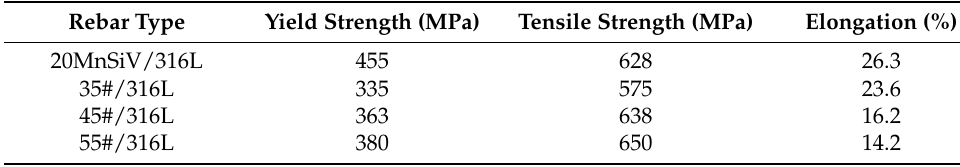
Table 5. Results of tensile experiments on various